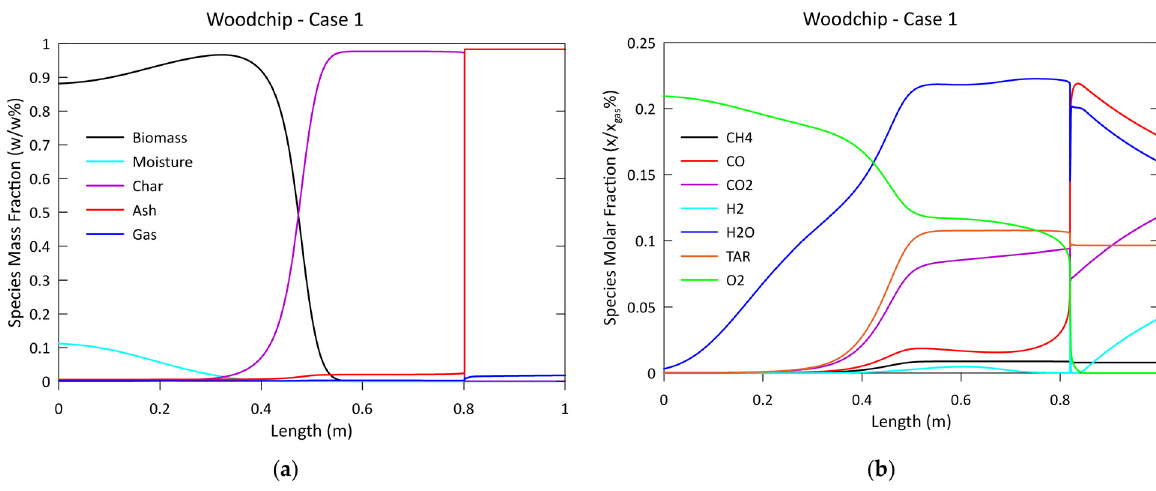
Figure 6. Numerical results on woodchip case 1 regarding the evolution of the mass fractions of the ( a ) solid and ( b ) gaseous